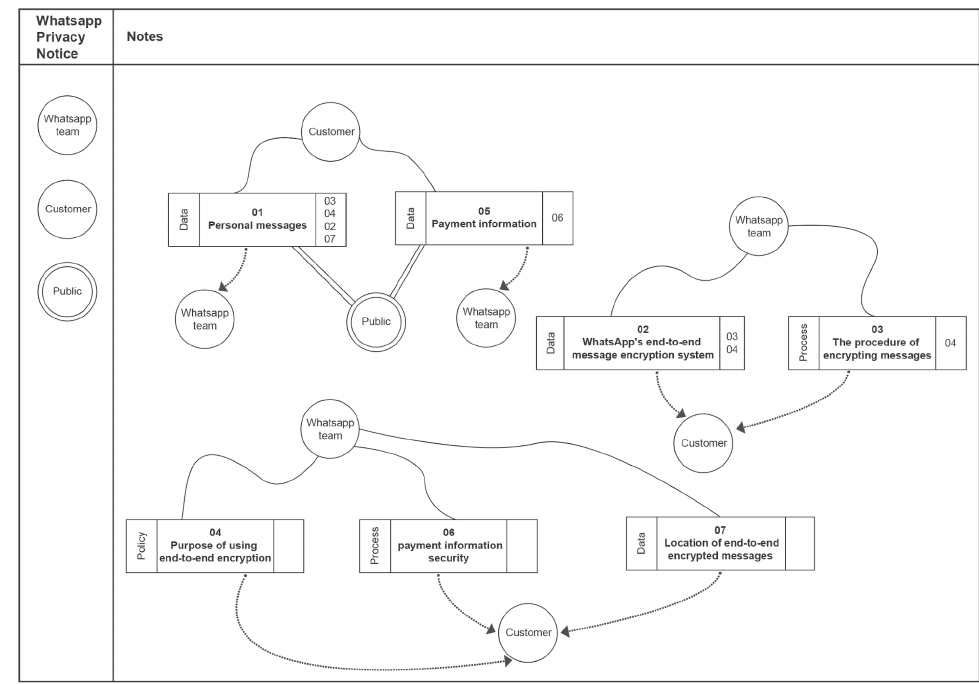
Figure A2. Shield diagram for the WhatsApp use